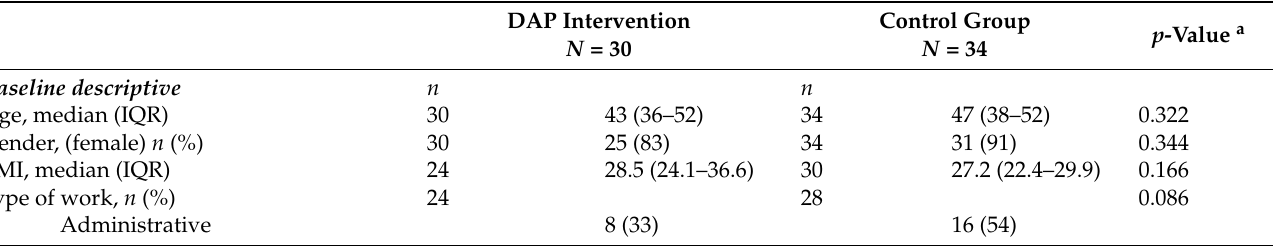
Table 2. Characteristics of the participants in the intervention group and the control group. DAP